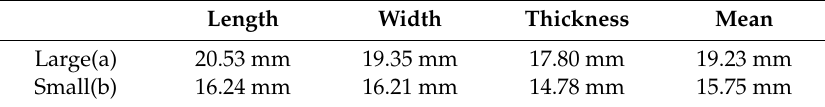
Table 1. Mean dimensions of 100 samples of each group of hazelnuts.